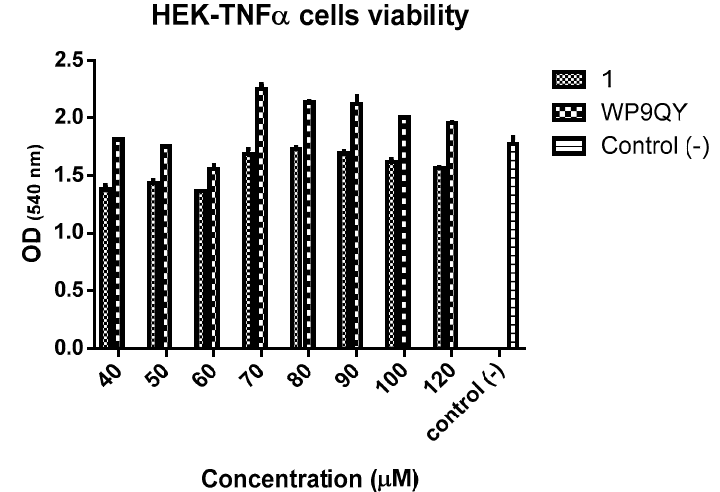
Figure 5. MTT assay of HEK-Blue TNF α cells in the presence of 1 and WP9QY. Optical density (OD) readings at 540 nm correspond to formazan levels formed by viable cells after incubation with 1 and WP9QY for 24 h. This assay was performed with one duplicate, and the error bars show standard error.